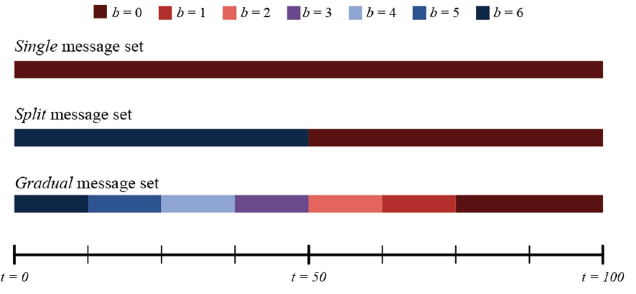
Fig 3. A graphical illustration of the different message sets. A visual depiction of the different message set conditions used in our in-silico experiments: single (top), split (middle), and gradual (bottom), set against a 100-step simulation from t = 0 to t =